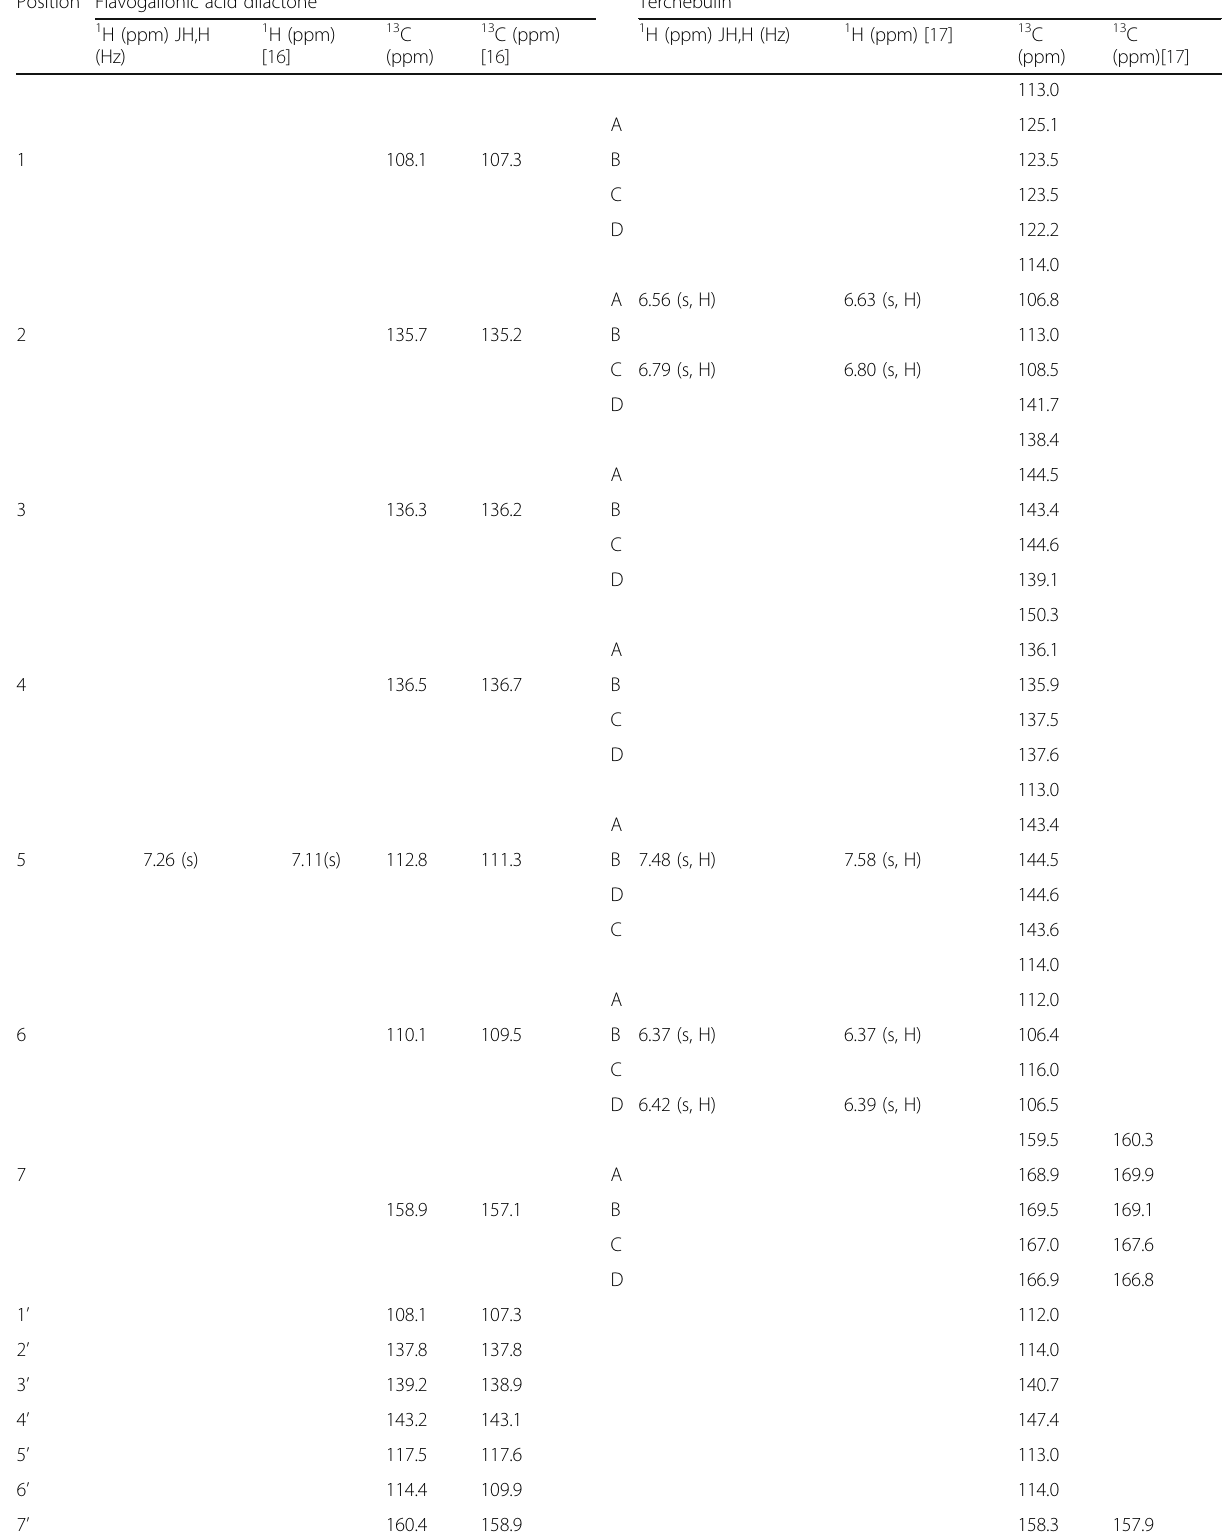
Table 2 1 H- and 13 C – NMR data of flavogallonic acid dilactone and terchebulin (in CD 3 OD) as compared with literature [16, 17] Position Flavogallonic acid dilactone